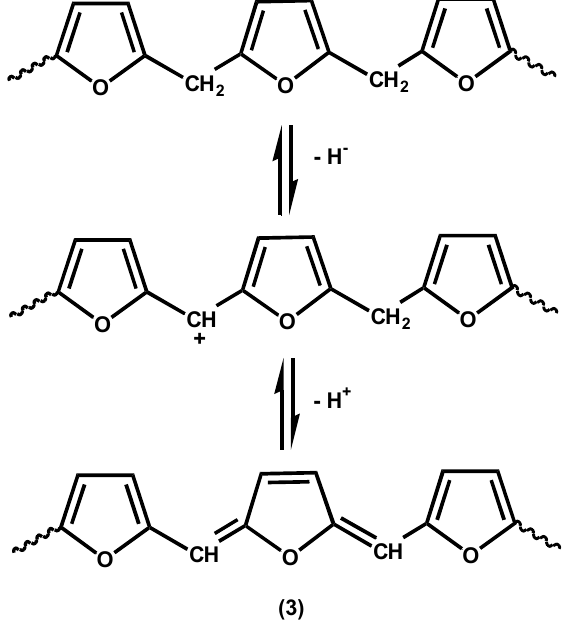
Scheme 3. Reaction suggested for the development of conjugated unsaturation, and hence colour, in polyfurfuryl alcohols